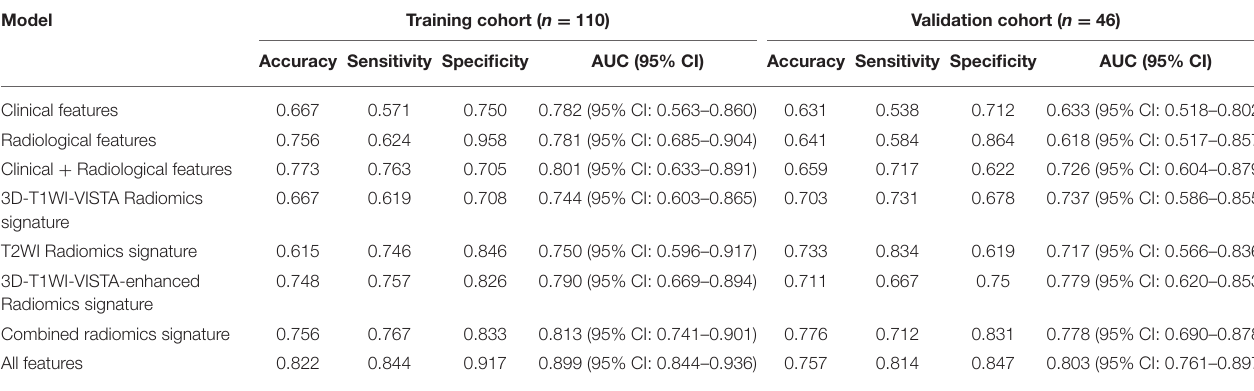
TABLE 3 | Prediction efficiency of different models in the training and validation